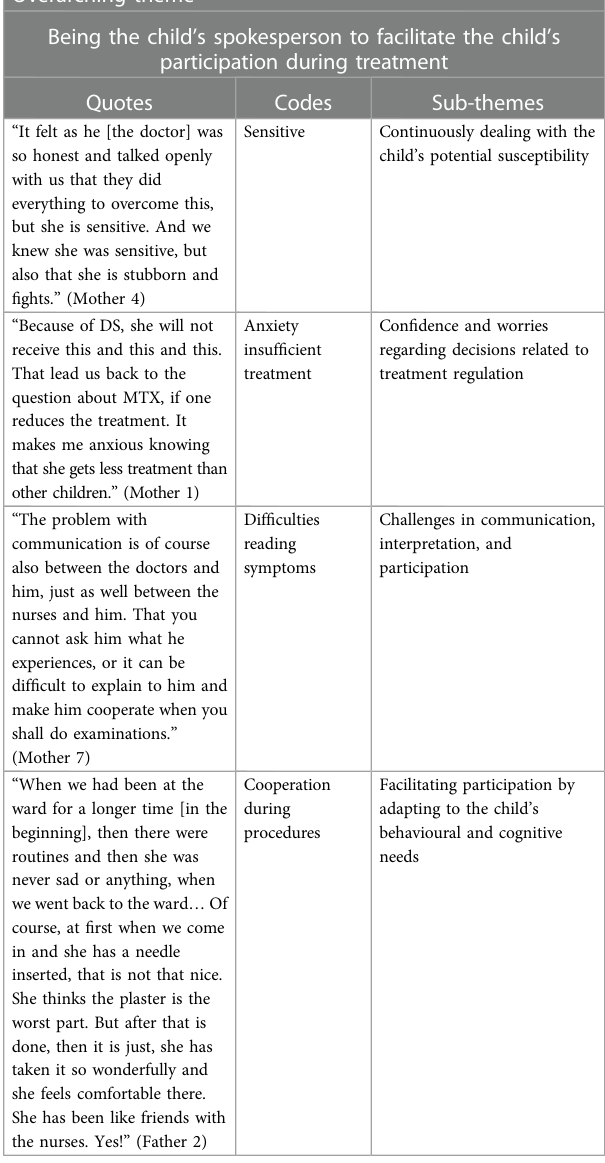
TABLE 4 Illustrations of quotes, codes and sub-themes. Overarching